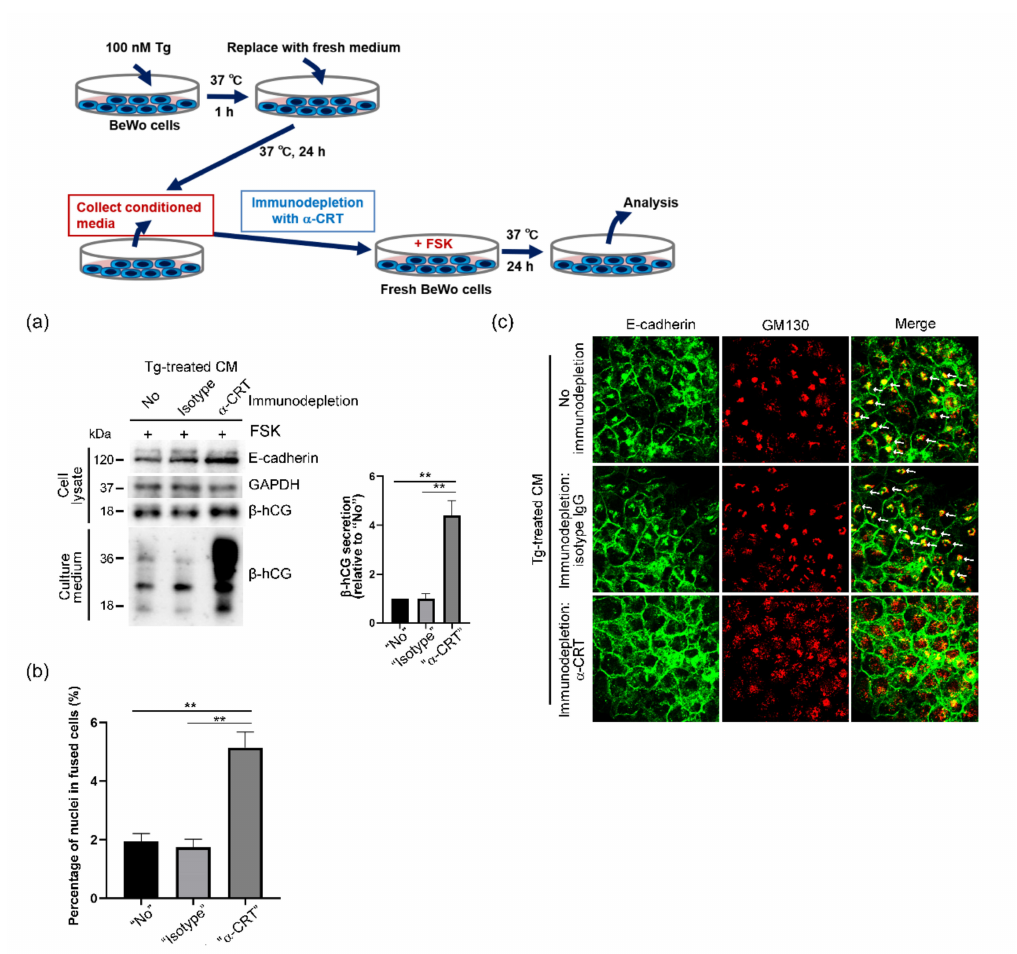
Figure 5. Elimination of detrimental effects of Tg-CM on BeWo cells by CRT immunodepletion. ( a ) BeWo cells were treated with thapsigargin (Tg) for 1 h at 37 ◦ C. After samples were washed three times with PBS, culture media were replaced with fresh Opti-MEM and cells were cultured for 24 h at 37 ◦ C. Conditioned medium samples were then collected to obtain Tg-CM. CRT in Tg-CM was immunodepleted by using an anti-CRT antibody and Dynabeads with protein G. Fresh BeWo cells were then treated with Tg-CM or CRT-depleted Tg-CM in the presence of forskolin (FSK, 80 µ M) for 24 h at 37 ◦ C, and expression of E-cadherin and secretion of β -hCG were analyzed via Western blotting. The graph shows quantification of secreted β -hCG. Data represent means ± SE (n = 3). ( b ) Effects of CRT immunodepletion from Tg-CM on syncytialization was analyzed by means of fusion indexes. Data represent means ± SE (n = 3). ( c ) Fresh BeWo cells were treated with Tg-CM or CRT-depleted Tg-CM in the presence of forskolin (80 µ M) for 24 h at 37 ◦ C, and subcellular localization of E-cadherin was analyzed by using immunofluorescence with anti-E-cadherin and anti-GM130 antibodies. Arrows point to condensed E-cadherin signals that colocalized with GM130. ** p <